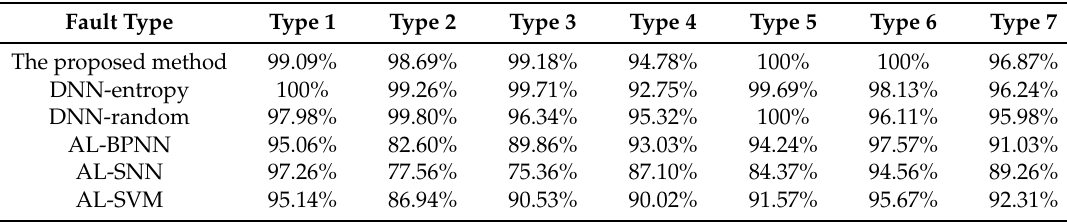
Table 3. Classification results obtained on the TE